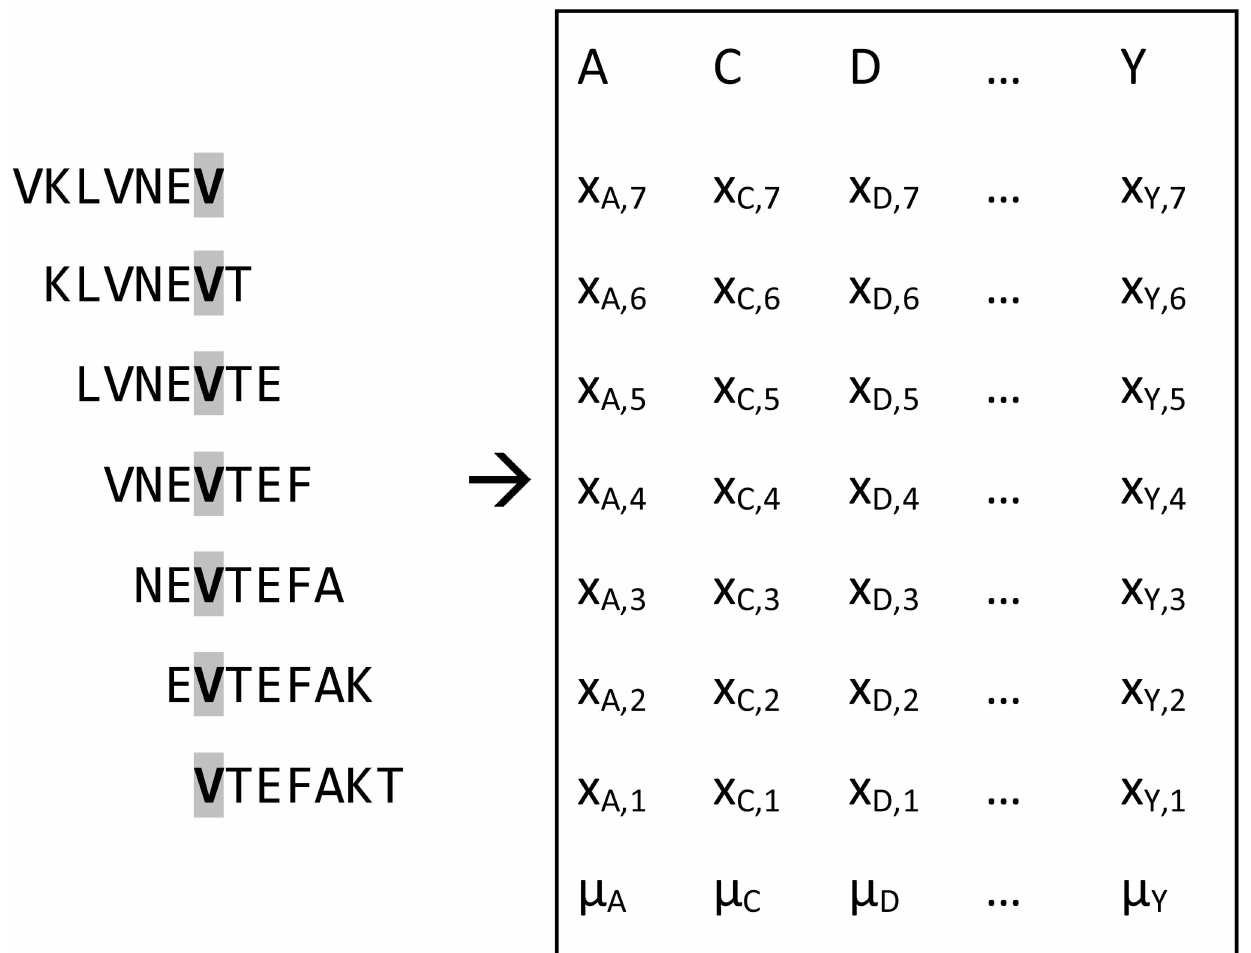
Fig 1. Example of substitution matrix. Figure showingoverlapping peptides (left) with the valine (V highlightedin bold) being analyzedfor antibody selectivity. The box containsthe substitutionvalues, x i , j , with columns representingthe amino acid, i , which substitutes valine and rows representingthe position, j , of the valinein the peptide(illustratedto the left) undergoingsubstitution. The mean substitutionvalue, μ i , of each replacingamino acid is shown in the bottom row. The globalmean, μ g , is calculatedacross all substitutionvalues in the